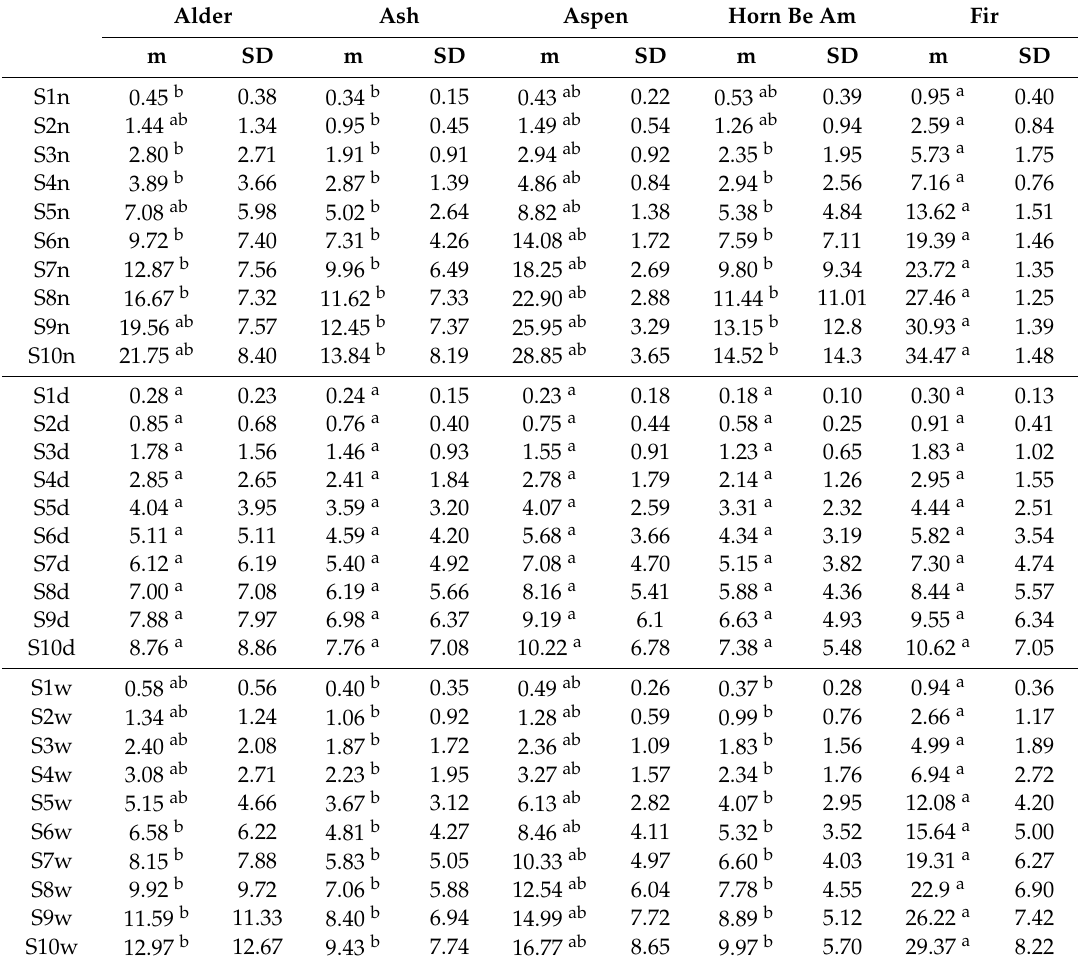
Table 1. Comparison of water storage capacity for the deadwood of each species at each stage of simulated